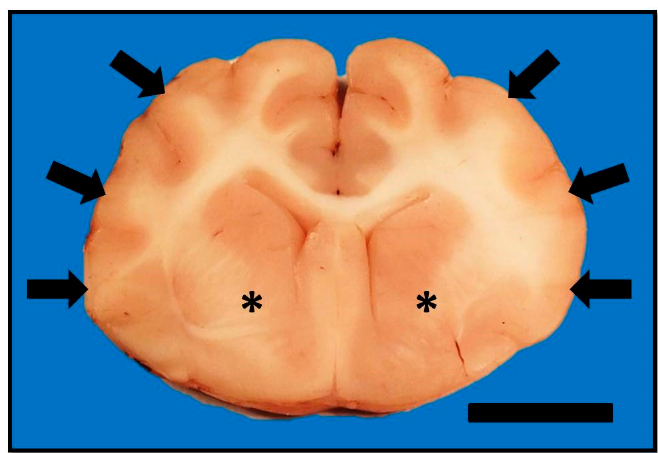
adhesion, colliculi, and midbrain (arrows). MRI scan.